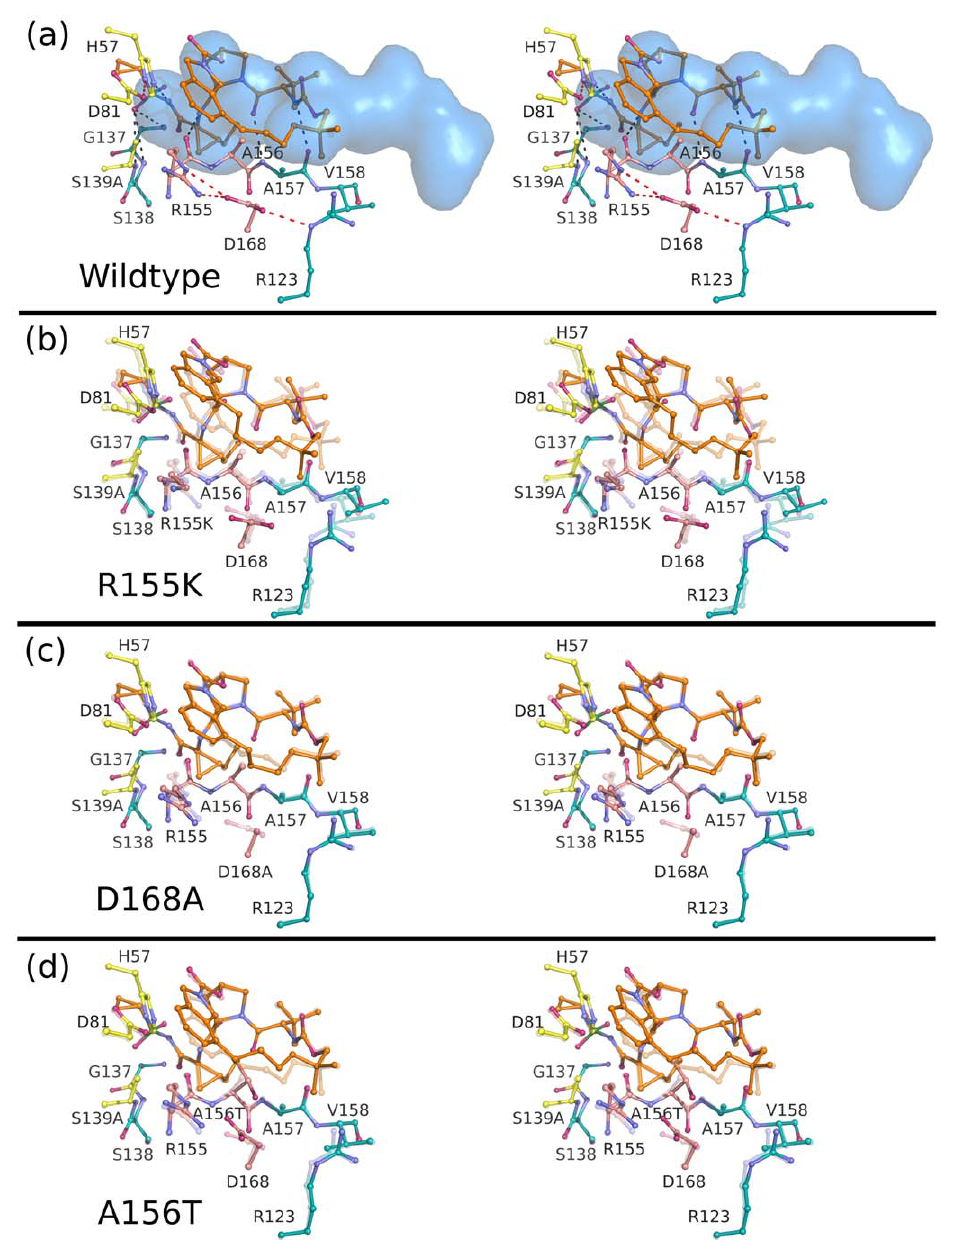
Figure 5. Stereo view of the vaniprevir complexes. (A) Vaniprevir bound to the wild-type protease with the substrate envelope in blue. Intra- and inter-molecular hydrogen bond interactions are marked as red and grey dashed lines. Vaniprevir is shown bound to the drug-resistant variants (B) R155K, (C) D168A and (D) A156T with the transparent coordinates representing the wild-type structure to better highlight the molecular changes of each mutation. In all cases, catalytic residues are depicted in yellow, the P2 subsite in pink, and the drug molecules in orange.